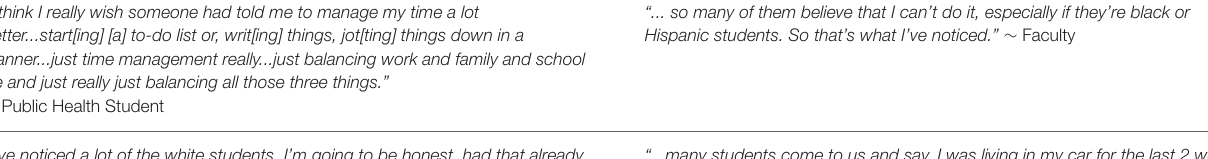
TABLE 7 | Academic stressors: illustrative comments from study